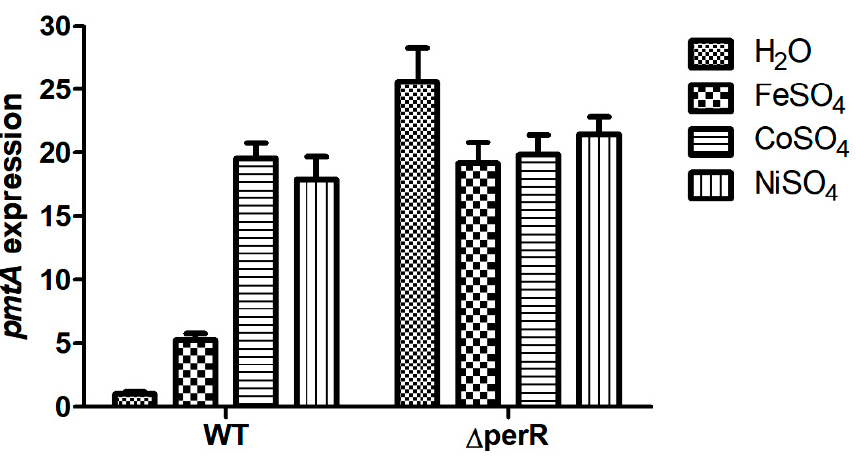
Figure 6. pmtA expression in the WT and ∆ perR strains in the absence and presence of ferrous